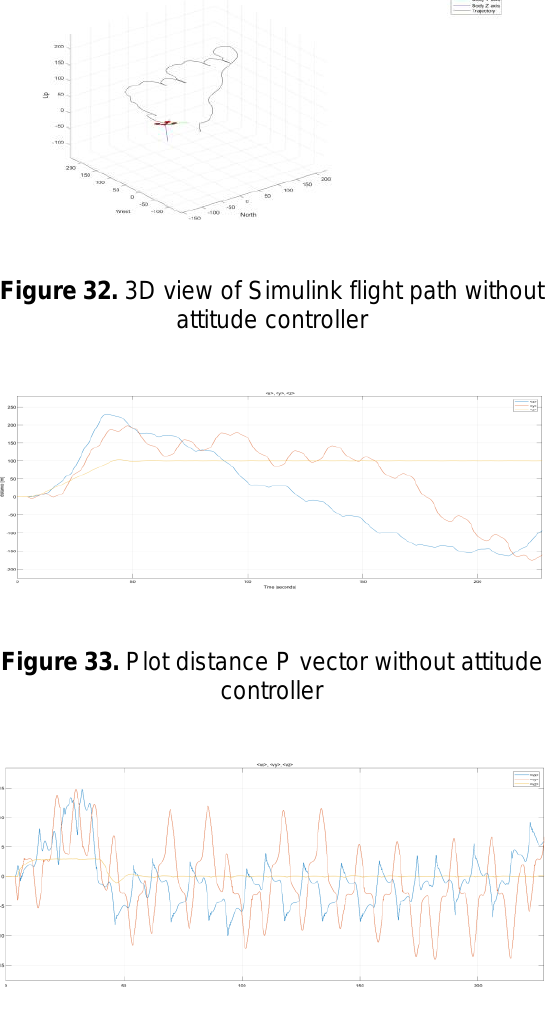
Figure 34. Plot linear velocity vector without attitude